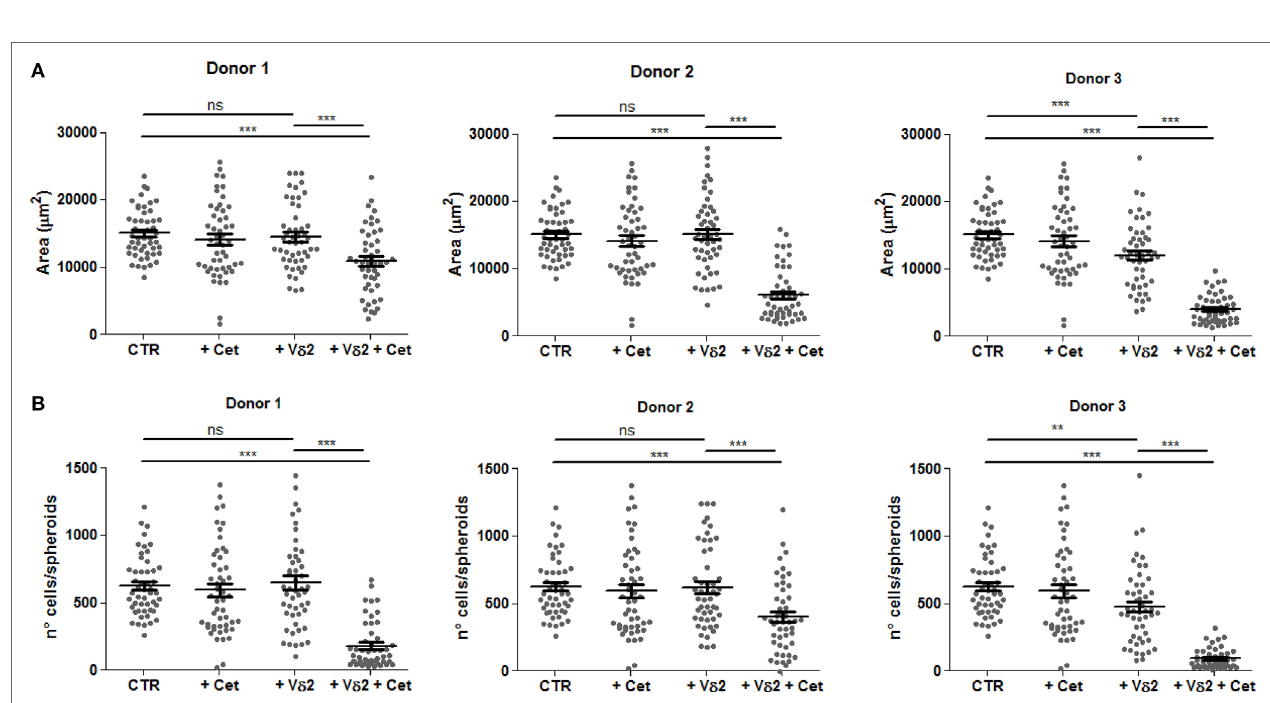
FIGURe 7 | V δ 2 T cells can be triggered by the anti-epidermal growth factor receptor (EGFR) therapeutic antibody cetuximab to reduce CRC spheroids. HCT15 spheroids were generated in serum free medium supplemented with epithelial growth factor (10 ng/ml). On day 6, cultures were incubated for additional 24 h in medium without (CTR) or with the anti-EGFR antibody cetuximab (2 µg/ml, + Cet) or V δ 2 T cells ( + V δ 2) or V δ 2 T cells and cetuximab (2 µg/ml, + V δ 2 + Cet). Then, each culture well was analyzed for the identification and measurement of spheroids. Data are representative of experiments obtained with three different V δ 2 T cell populations in triplicate wells for each donor. Each symbol in the plot indicates a single tumor cell spheroid. Data are expressed as area of spheroids [ (A) ; μ m 2 ] or cell number in each spheroid (B) . Bar: mean ± SEM of that group of measures. ** p < 0.01; *** p < 0.001; ns, not significant.